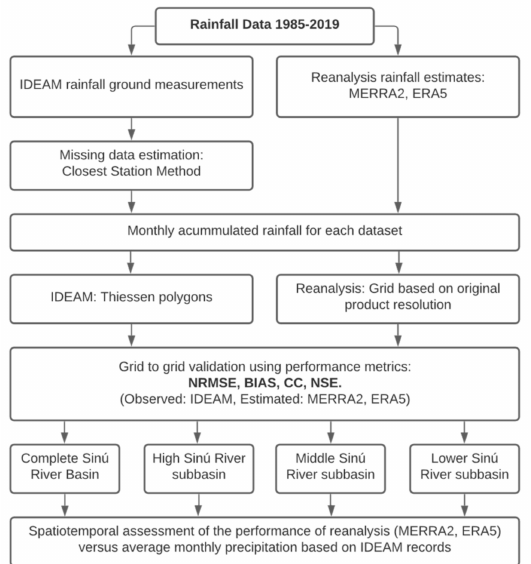
Figure 2. Diagram representing the method adopted in this research to assess MERRA2 and ERA5 rainfall products in the Sin ú River basin and